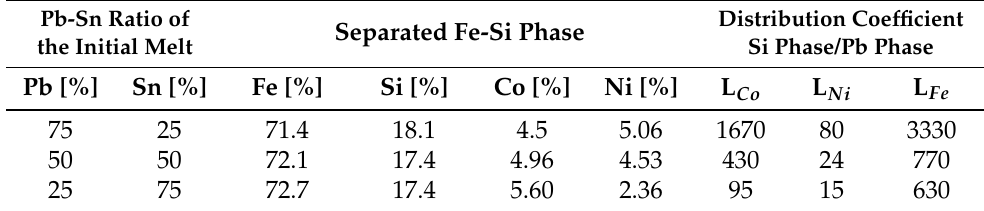
Table 1. Results of the investigations of Yazawa and others